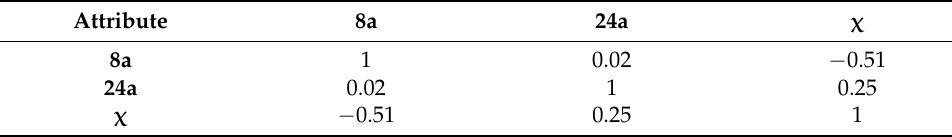
Table 1. Pearson correlations obtained for model